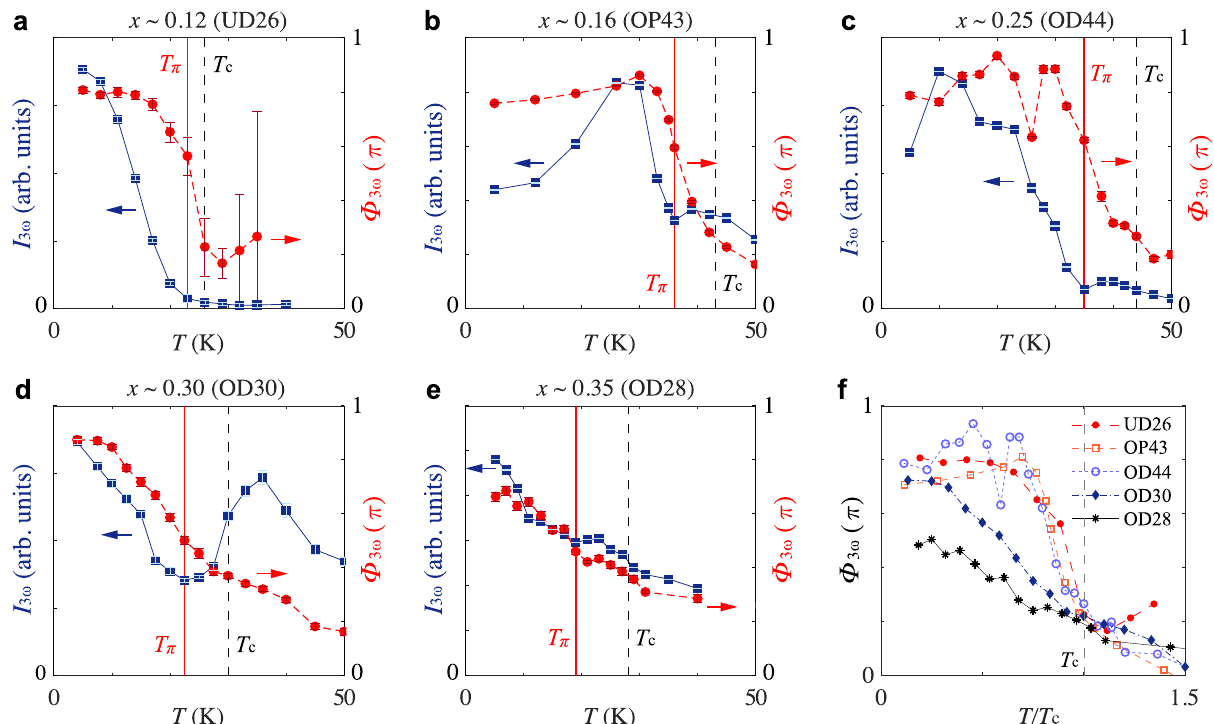
a x ~0.12 (UD26), b x ~0.16 (OP43), c x ~0.25 (OD44), d x ~0.30 (OD30), e x ~0.35 (OD28). The peak terahertz driving fi eld strength used for these measurements are a ~10kV/cm, b ~25kV/cm, c ~25kV/cm, d ~25kV/cm, and e ~20kV/cm. f Temperature dependence of Φ 3 ω from all fi ve samples plotted on the reduced temperature( T / T c )scale.Theanti-resonancebecomesincreasinglybroadenedwith hole-doping, indicating a broadening ofthe coupled modeon the overdoped